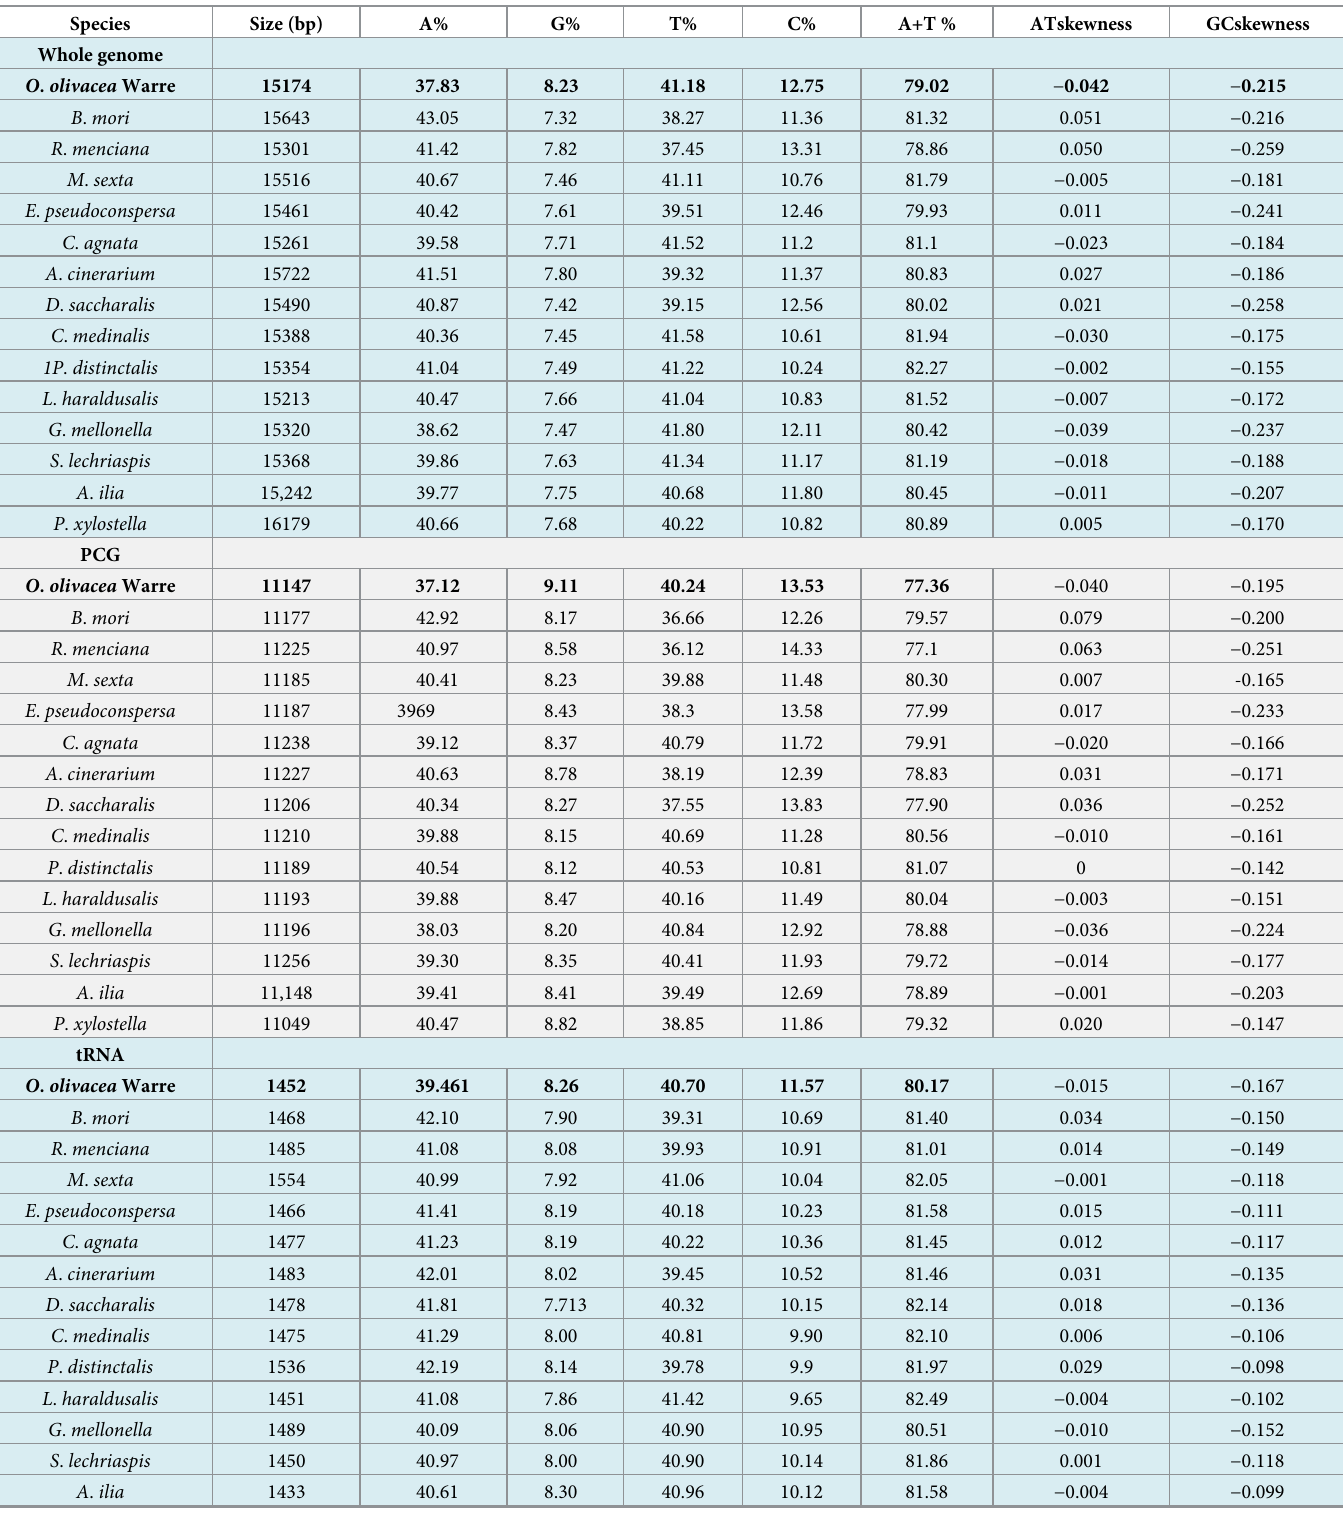
Table 4. Composition and skewness in different Lepidopteran mitogenomes.